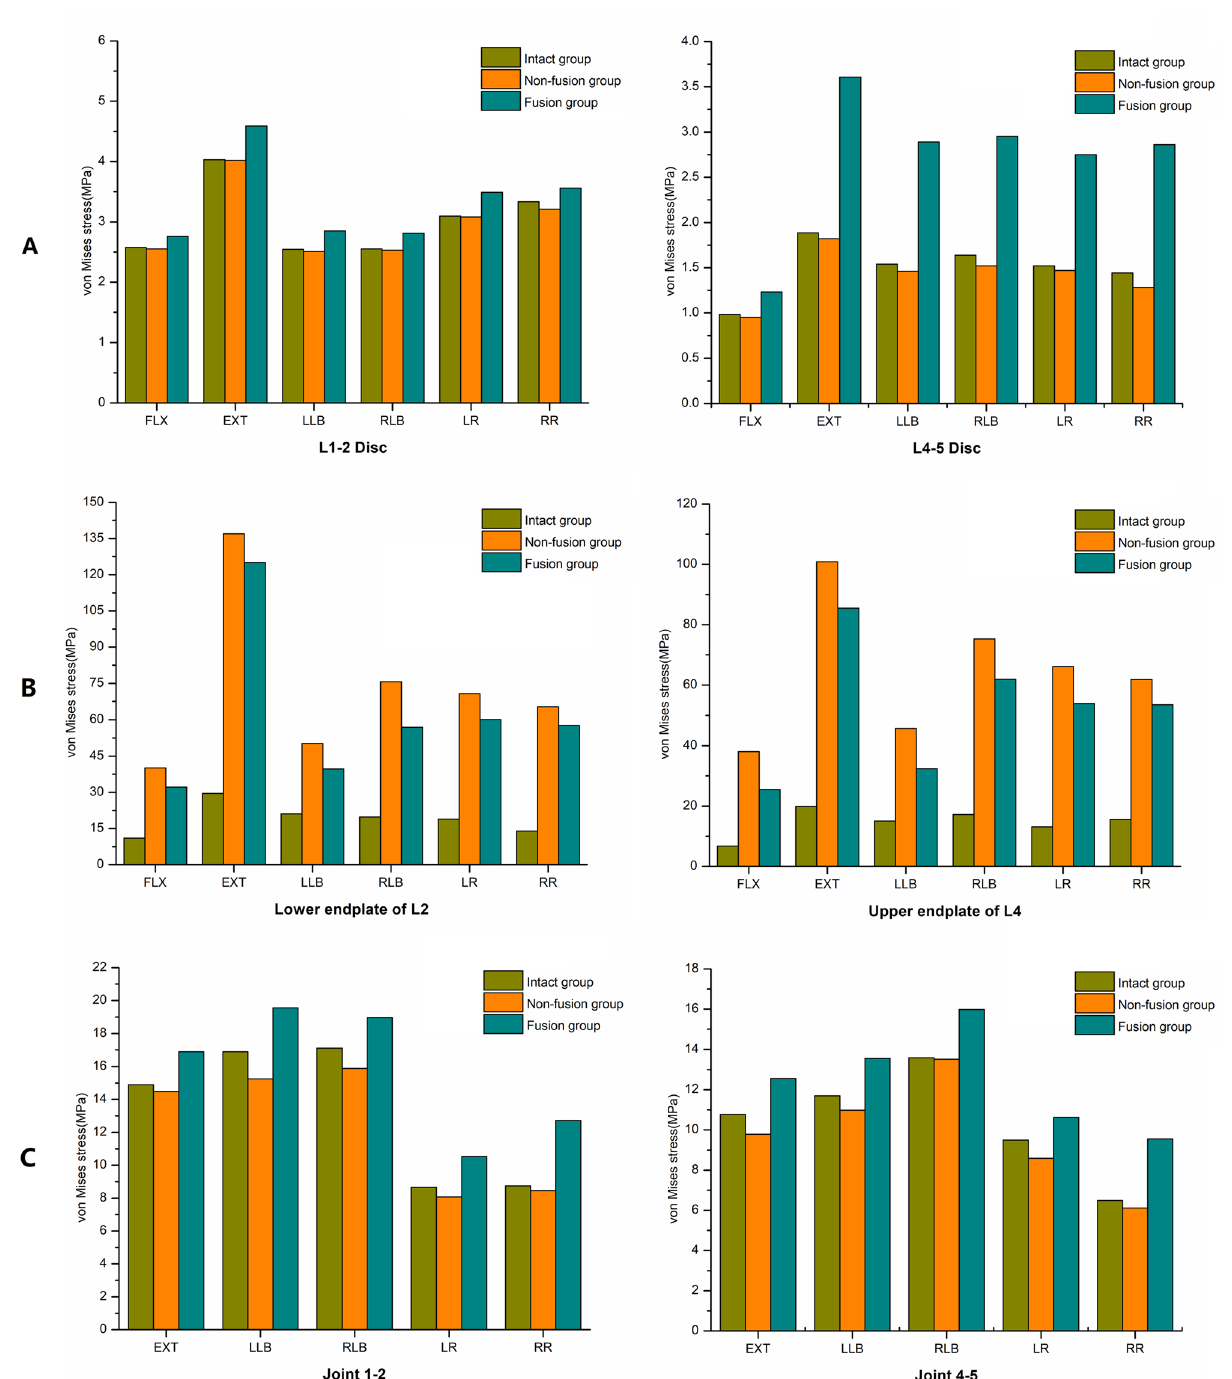
Figure 3. Comparisons of von Mises stress peaks: ( A ) adjacent disc stress, ( B ) endplate stress, ( C ) facet joint Facet joint stress. The von Mises stress peaks and the stress distributions of the adjacent facet joints (J12 and J45) are shown in Figs. 3C and 4, respectively. The maximum von Mises stresses of J12 in extension, left lateral bending, right lateral bending, left rotation and right rotation in the nonfusion group were 14.48 MPa, 15.25 MPa, 15.89 MPa, 8.07 MPa and 8.45 MPa, respectively, which were similar with those in the intact group (14.89 MPa, 16.89 MPa, 17.11 MPa, 8.65 MPa, and 8.75 MPa, respectively) but significantly lower than those in the fusion group (16.89 MPa,19.56 MPa, 18.96 MPa, 10.54 MPa, and 12.72 MPa, respectively). The corresponding maximum von Mises stresses of J45 in the nonfusion group were 6.12–13.52 MPa, which were obviously lower than those in the fusion group (9.56–15.98 MPa) but similar with those in the intact group (6.48–13.59 MPa).